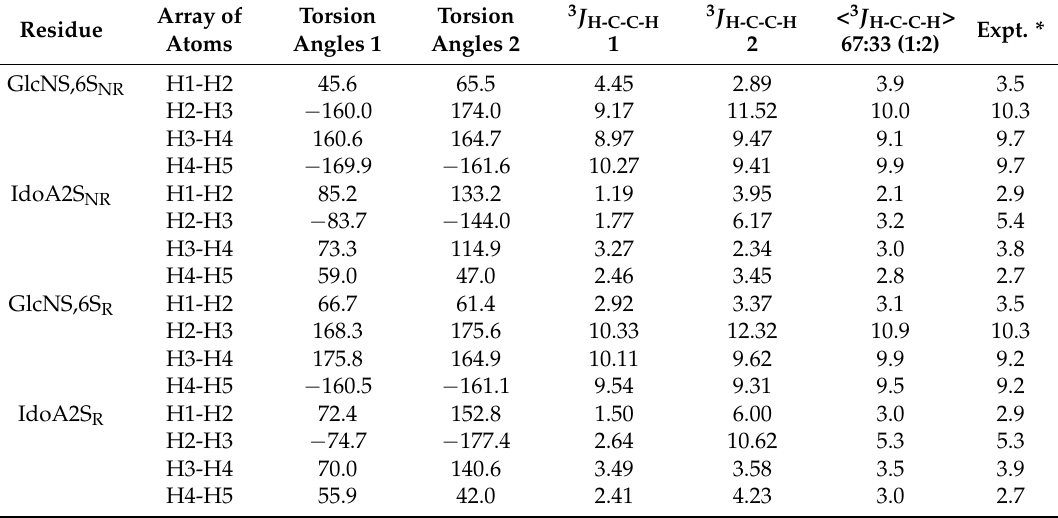
Table 4. Selected computed torsion angles and three-bond proton–proton coupling constants (values in Hz) in heparin tetrasaccharide. The two forms ( 1 and 2 ) correspond to different conformations ( 1 C 4 and 2 S 0 ) of the IdoA2S residues. The GlcNS,6S residues are in the 4 C 1 conformation. < 3 J H-C-C-H > was computed as a weighted average using data presented in columns 5 and 6 using the ratio 67:33 ( 1 : 2 ). Experimental values are shown in the last